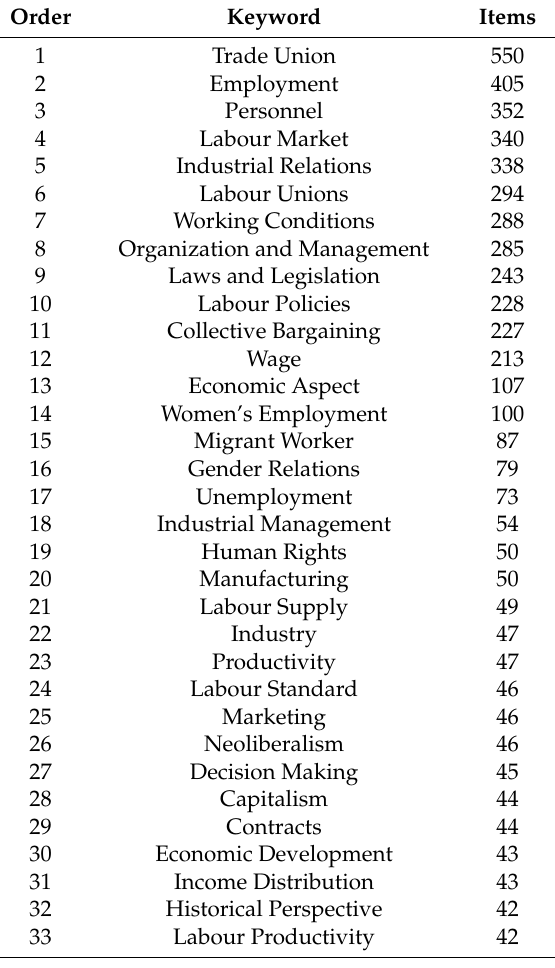
Table 3. Most relevant keywords related to labour relations. Order Keyword